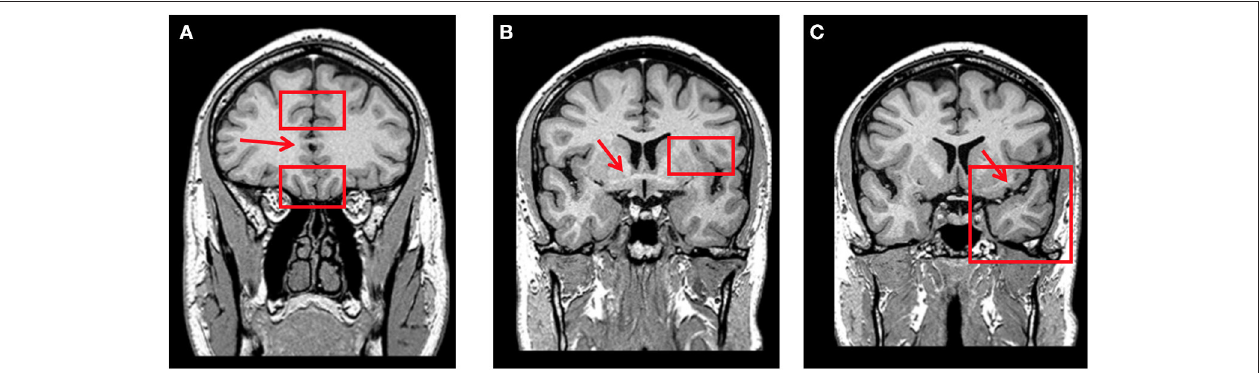
FIGURE 1 | (A) Coronal T1-weighted MRI at the level where the corpus callosum is first visible (red arrow). Orbitofrontal cortex is rated through the olfactory sulcus (lower red rectangle) and rostral anterior cingulate cortex through the cingulate sulcus (upper red rectangle) on this slice. (B) Coronal T1-weighted MRI at the level where the anterior commissure is first visible (red arrow). Fronto-insular cortex is rated through the circular sulcus (left-side red rectangle) on this slice and the two posterior. (C) Coronal T1-weighted MRI at the level where the connection between the frontal and temporal lobes is no more visible (left-side red arrow). Anterior temporal cortex is rated in this slice (left-side red